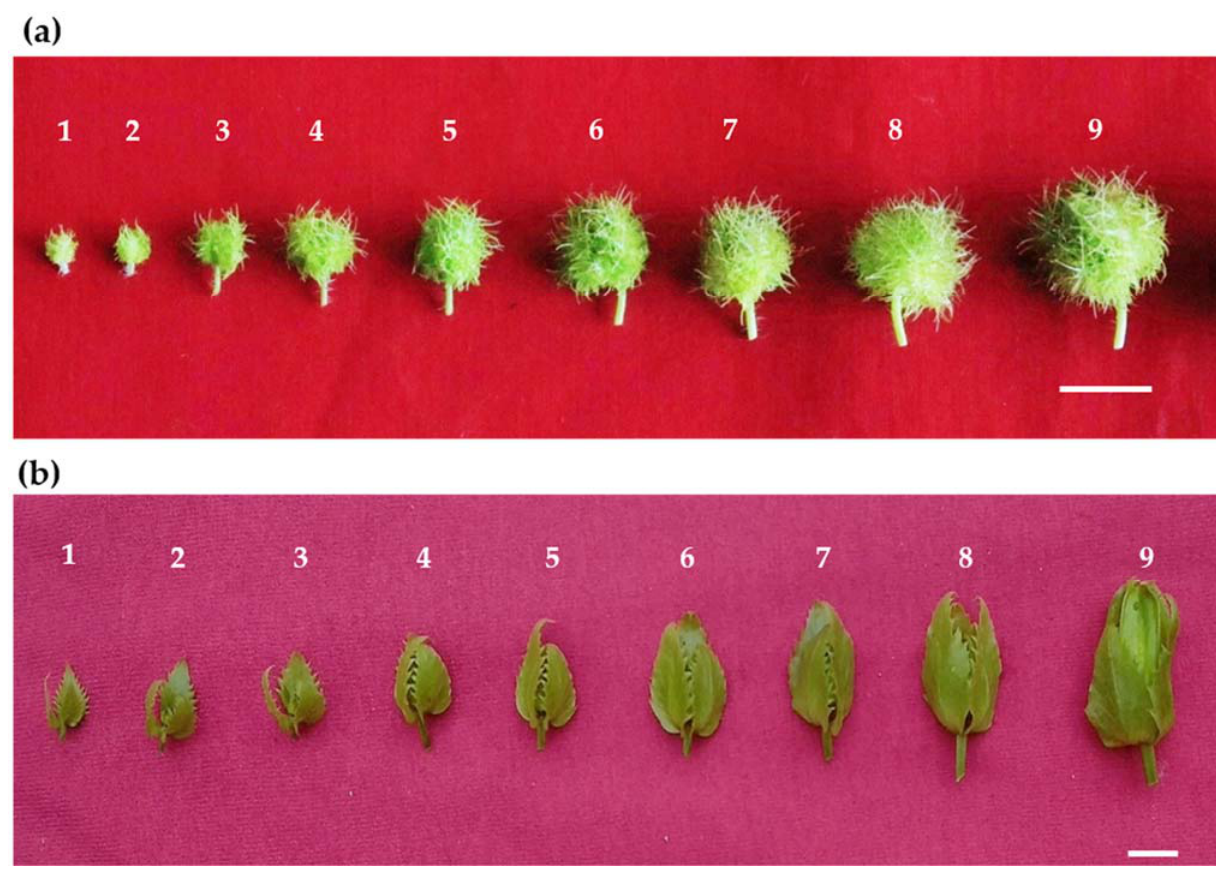
Figure 1. Morphological differences in developmental stages of the floral buds between ( a ) P. foetida (wild) and ( b ) P. edulis (cultivated) species considered for the ovule development study (scale bar = 1 cm).